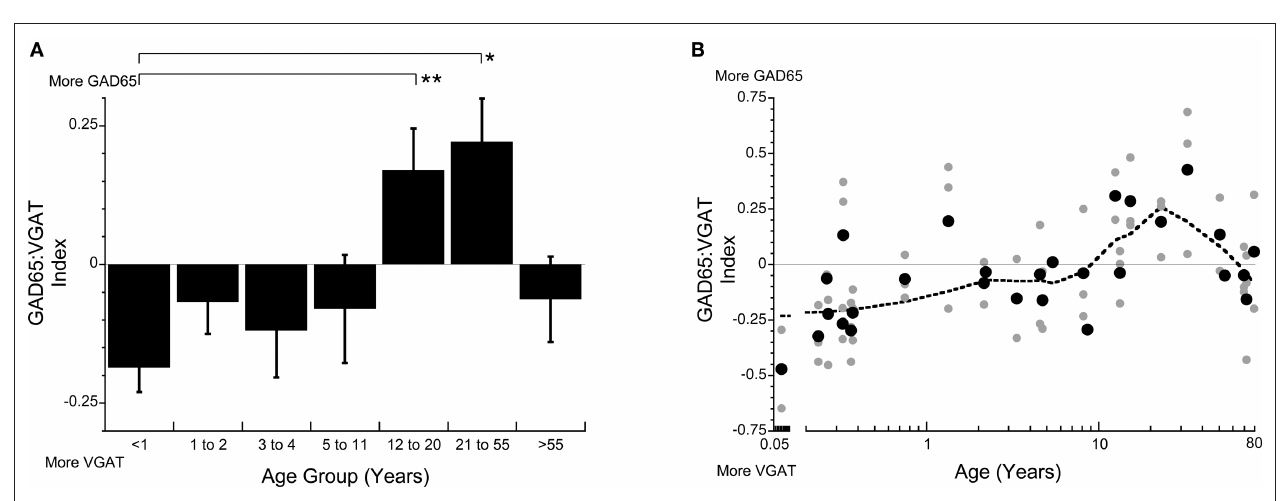
FiGure 3 | The index of GAD65:VGAT (A,B) gives insight into the relative balance between production and trafficking of GABA. The balance is in favor of VGAT early ( < 11 years) and late ( > 55 years) in development, but there is much more GAD65 during the teenage to adult years (12–55 years) (Kruskal–Wallis,